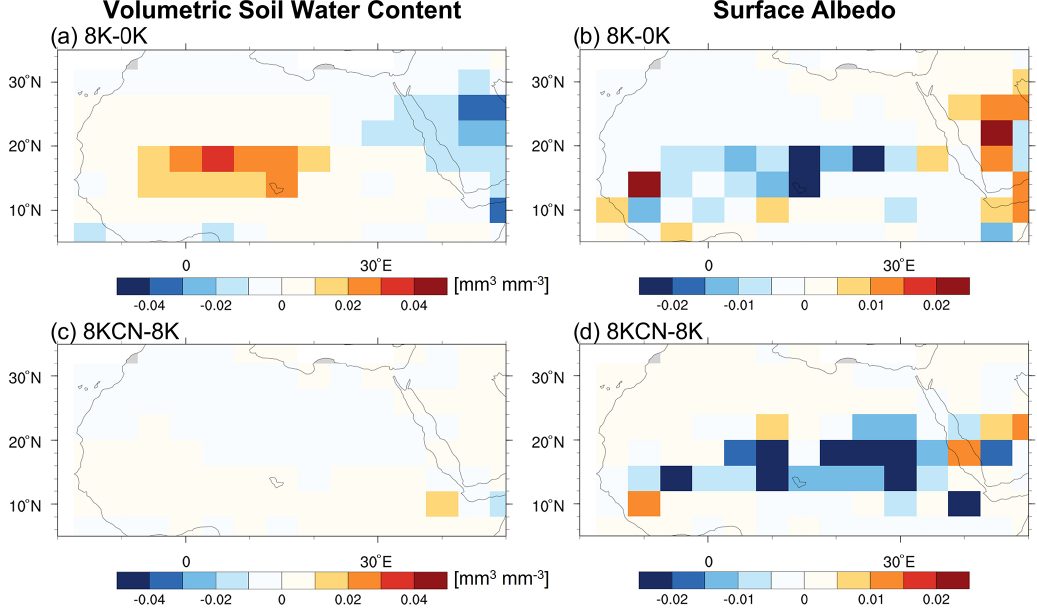
Figure 8. Differences in volumetric soil water content (a, c) and surface albedo (b, d) between the 0K, 8K, and 8KCN experiments. The first and second rows show the differences between the 8K and 0K and between the 8KCN and 8K experiments, respectively.